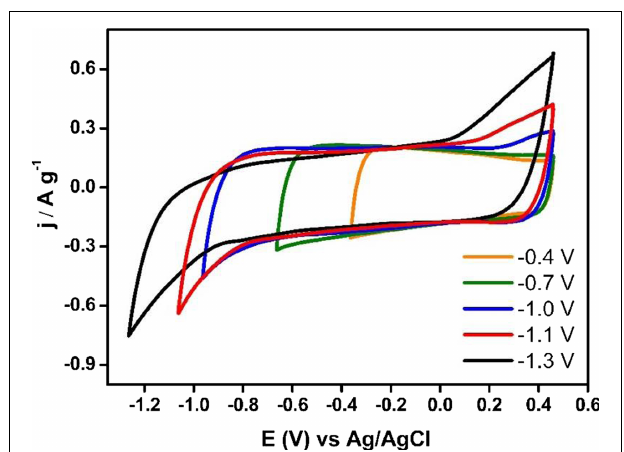
FIGURE 4 | Steady voltammograms of Ank4 toward negative potentials ( υυυ = 1mVs (cid:0) 1 ; 0.5M Na 2 SO 4 ) .